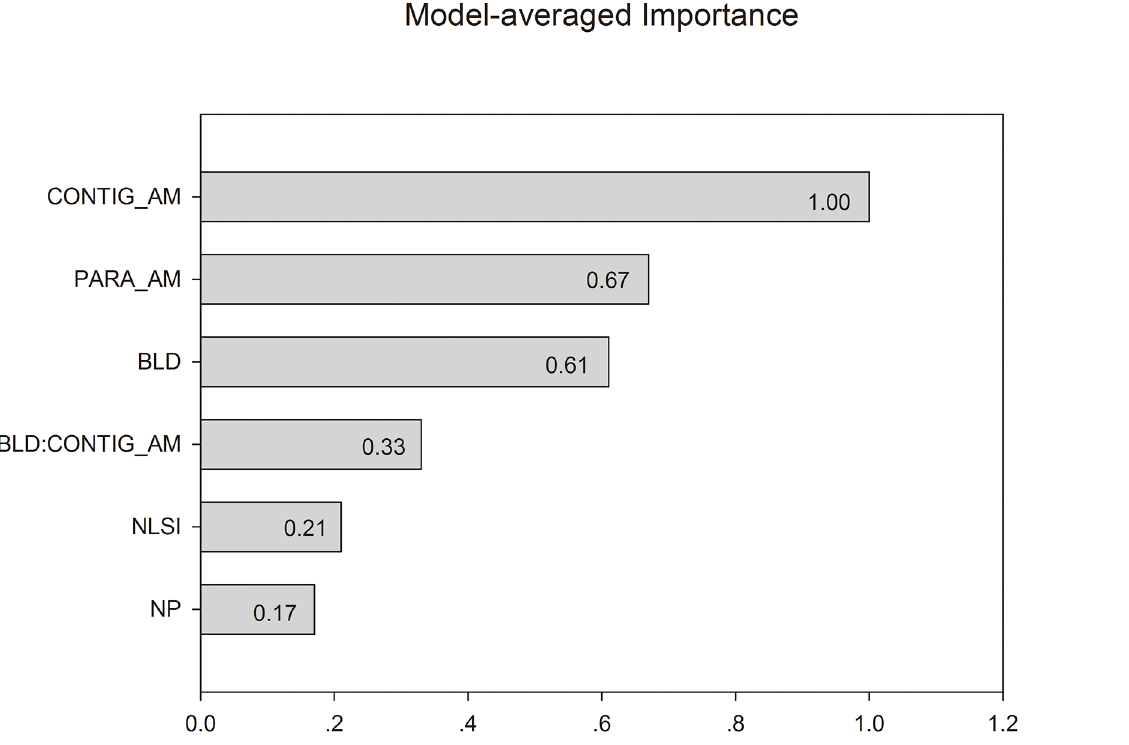
Fig 3. The importance of predictor variables to Scaly-sided Merganser occurrence based on the sum of AIC w over all models listed in Table